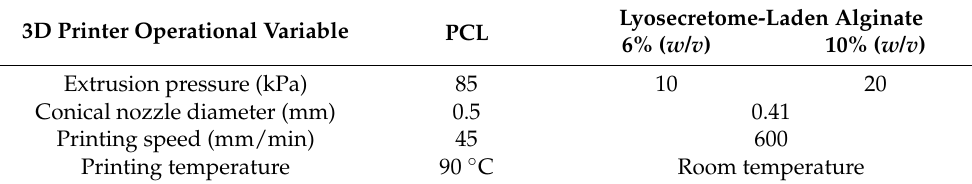
Table 1. Summary of 3D printer operational variables used for the